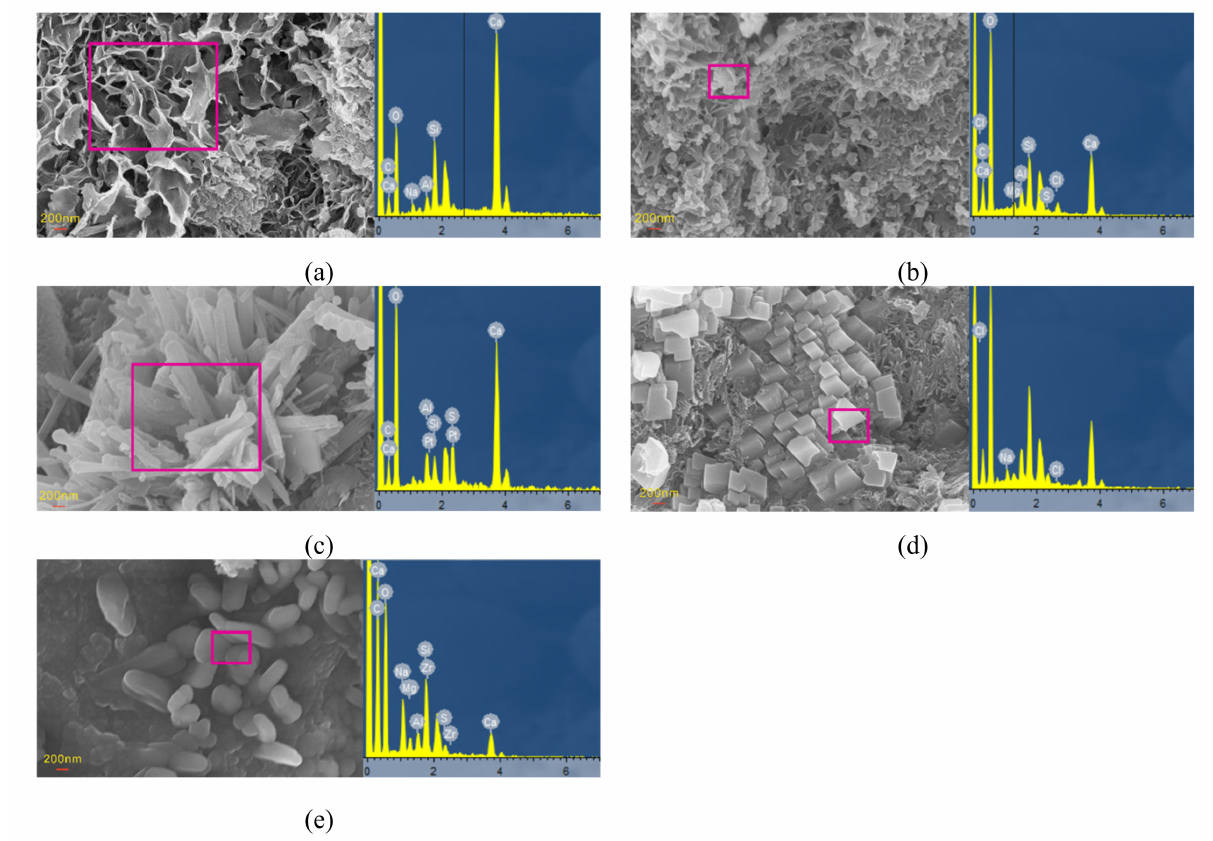
Figure 10. Microstructures and EDS results of selected region of concrete after corrosion for the specimen: ( a ) C-S-H,